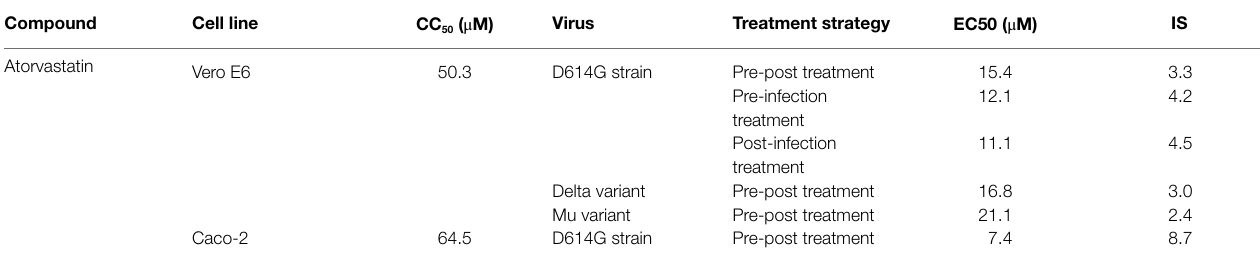
TABLE 2 | CC50, EC50, and SI values for ATV in Vero E6 and Caco-2 cells infected with SARS-CoV-2.